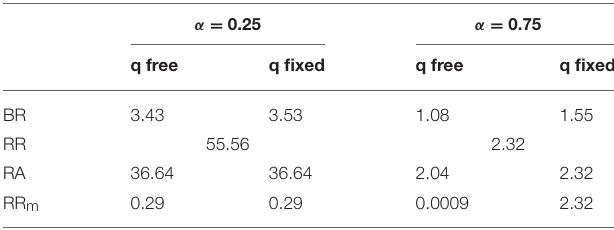
TABLE 2 | Residual least squares for each decision rule and the two starting point conditions. α =